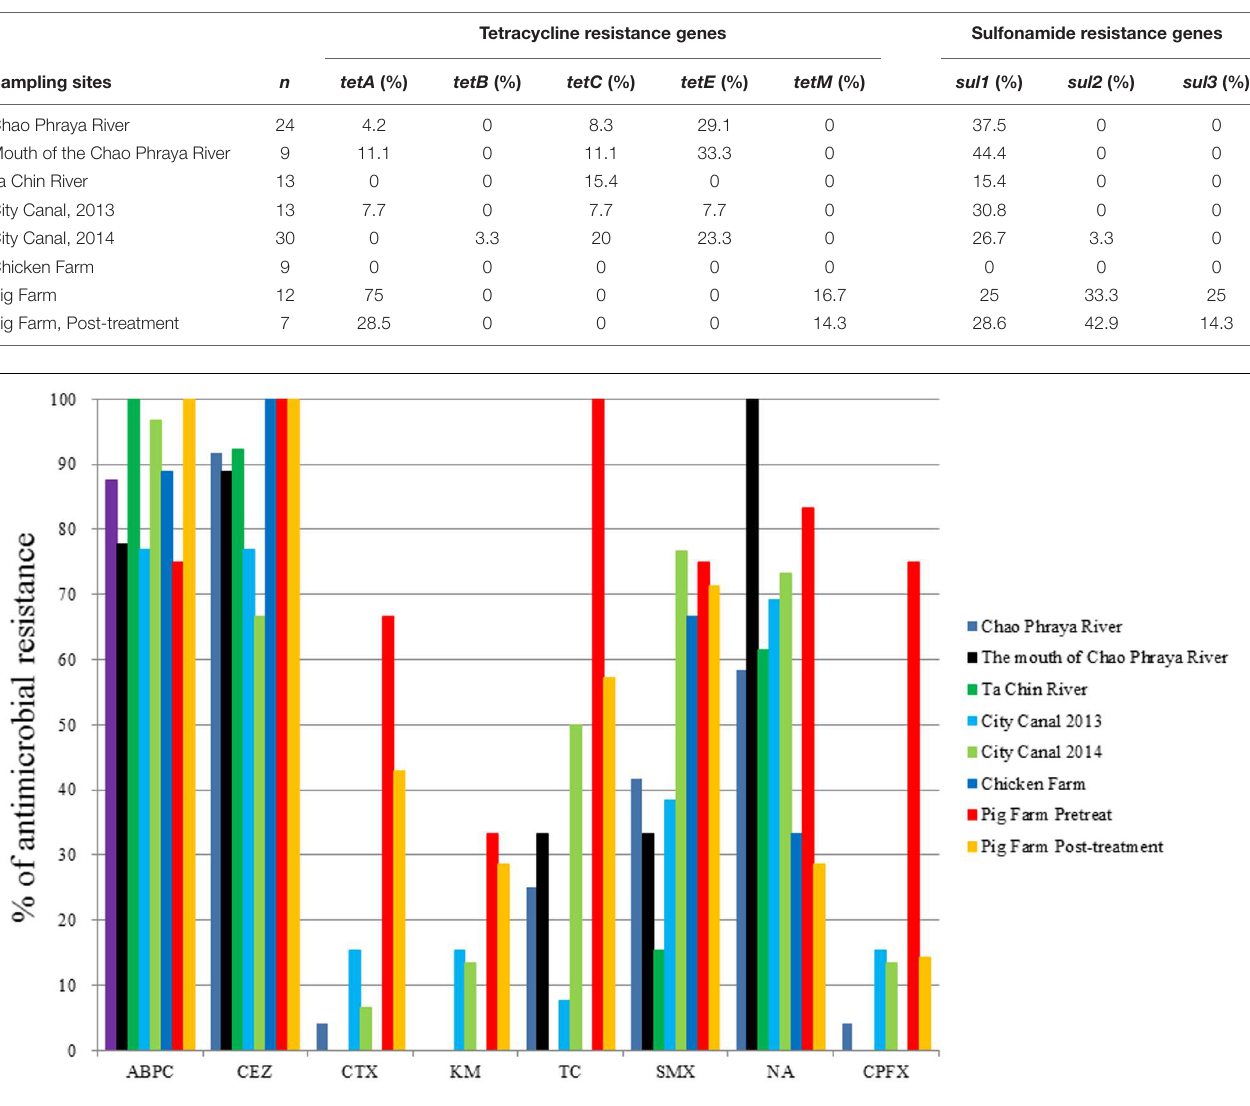
FIGURE 2 | Antimicrobial resistance rates of Aeromonas spp. obtained from several aquatic environments. ABPC, ampicillin; CEZ, cefazolin; CTX, cefotaxime; KM, kanamycin; TC, tetracycline; SMX, sulfamethoxazole; NA, nalidixic acid; CPFX,